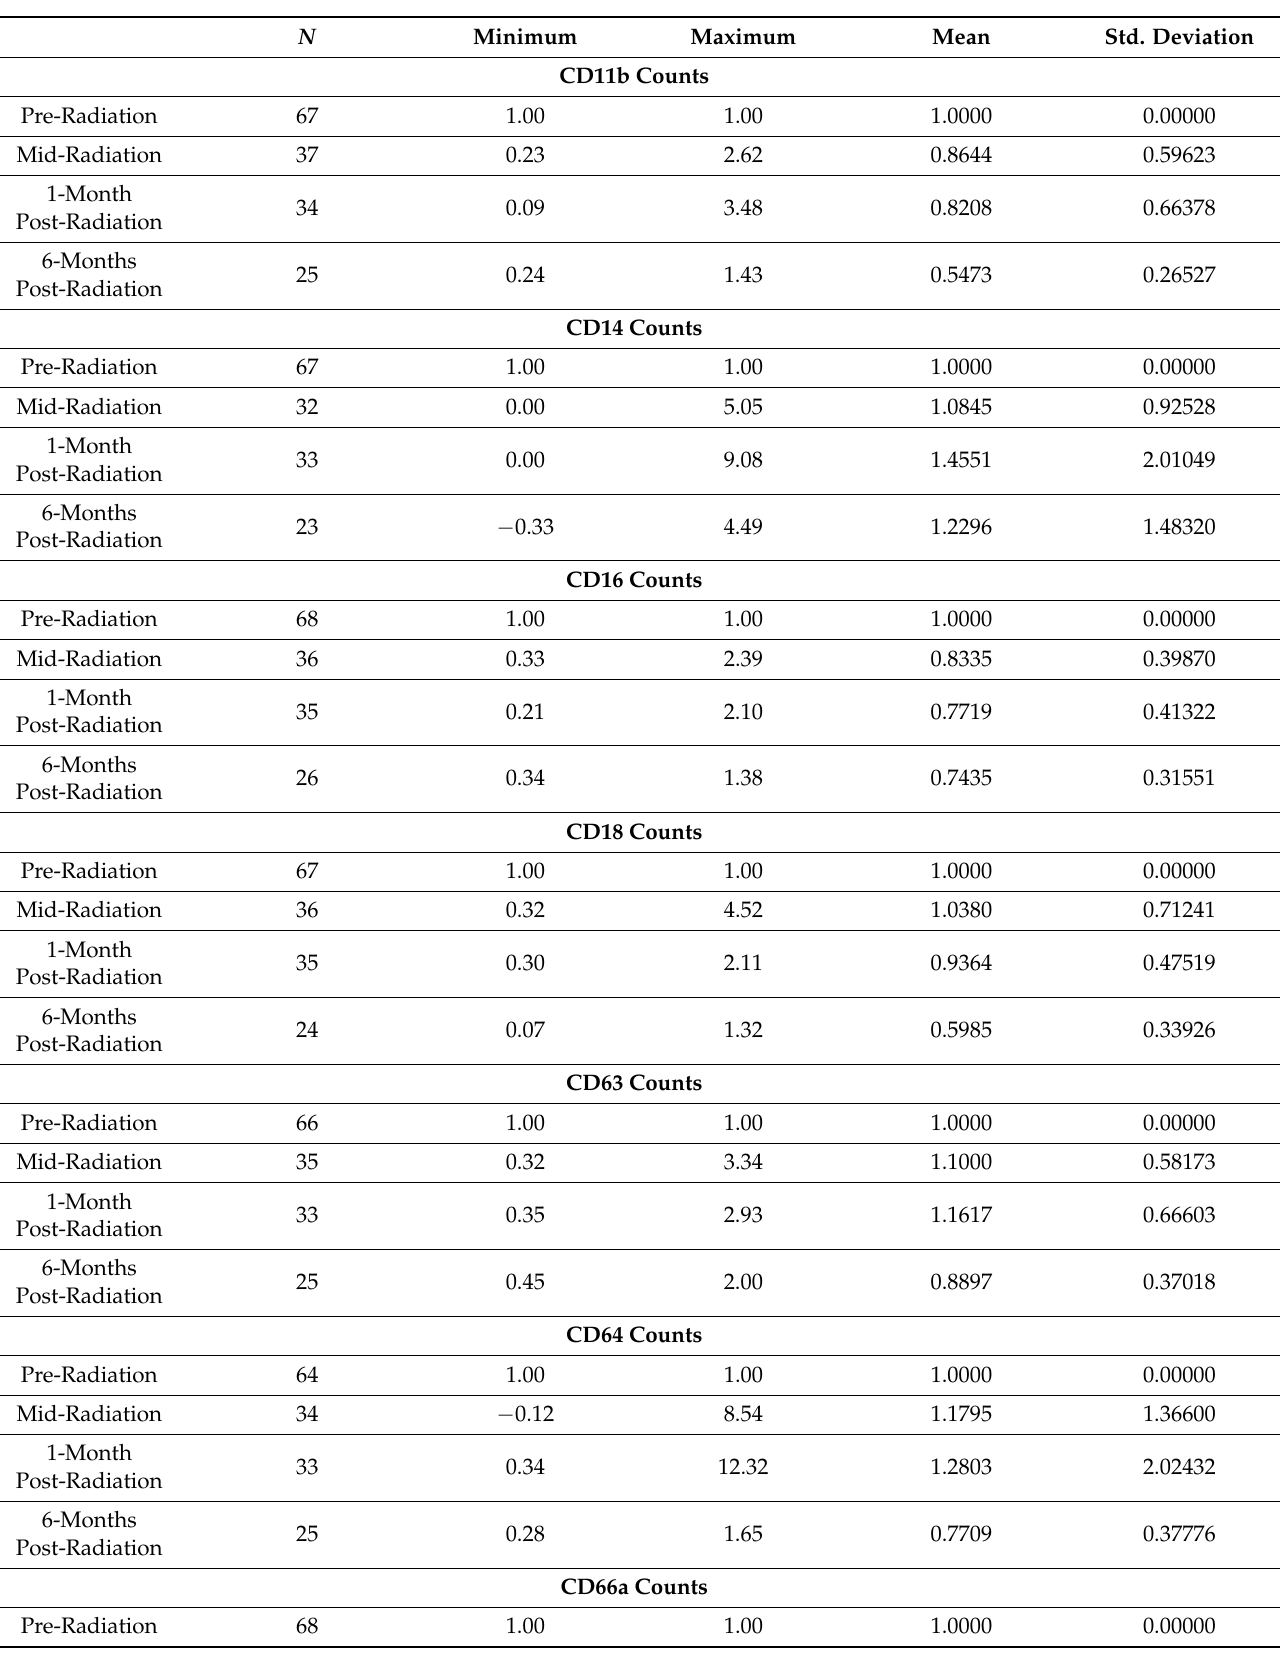
Table A9. oPMN marker fold-change and descriptive